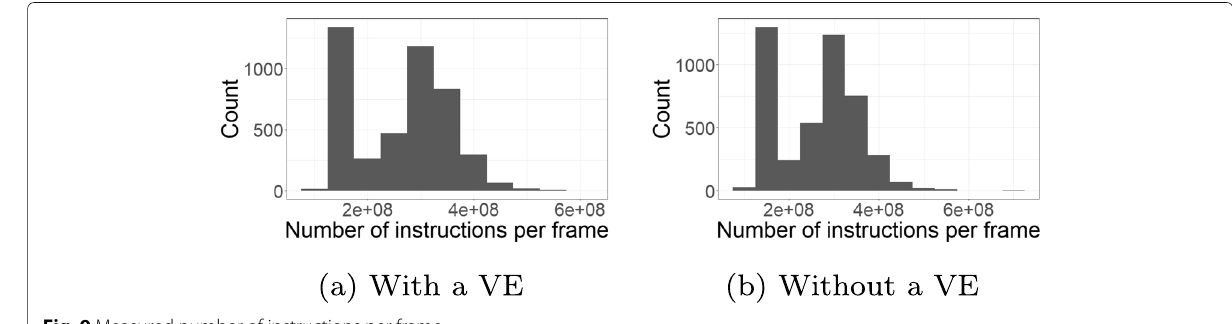
Fig. 9 Measured number of instructions per frame